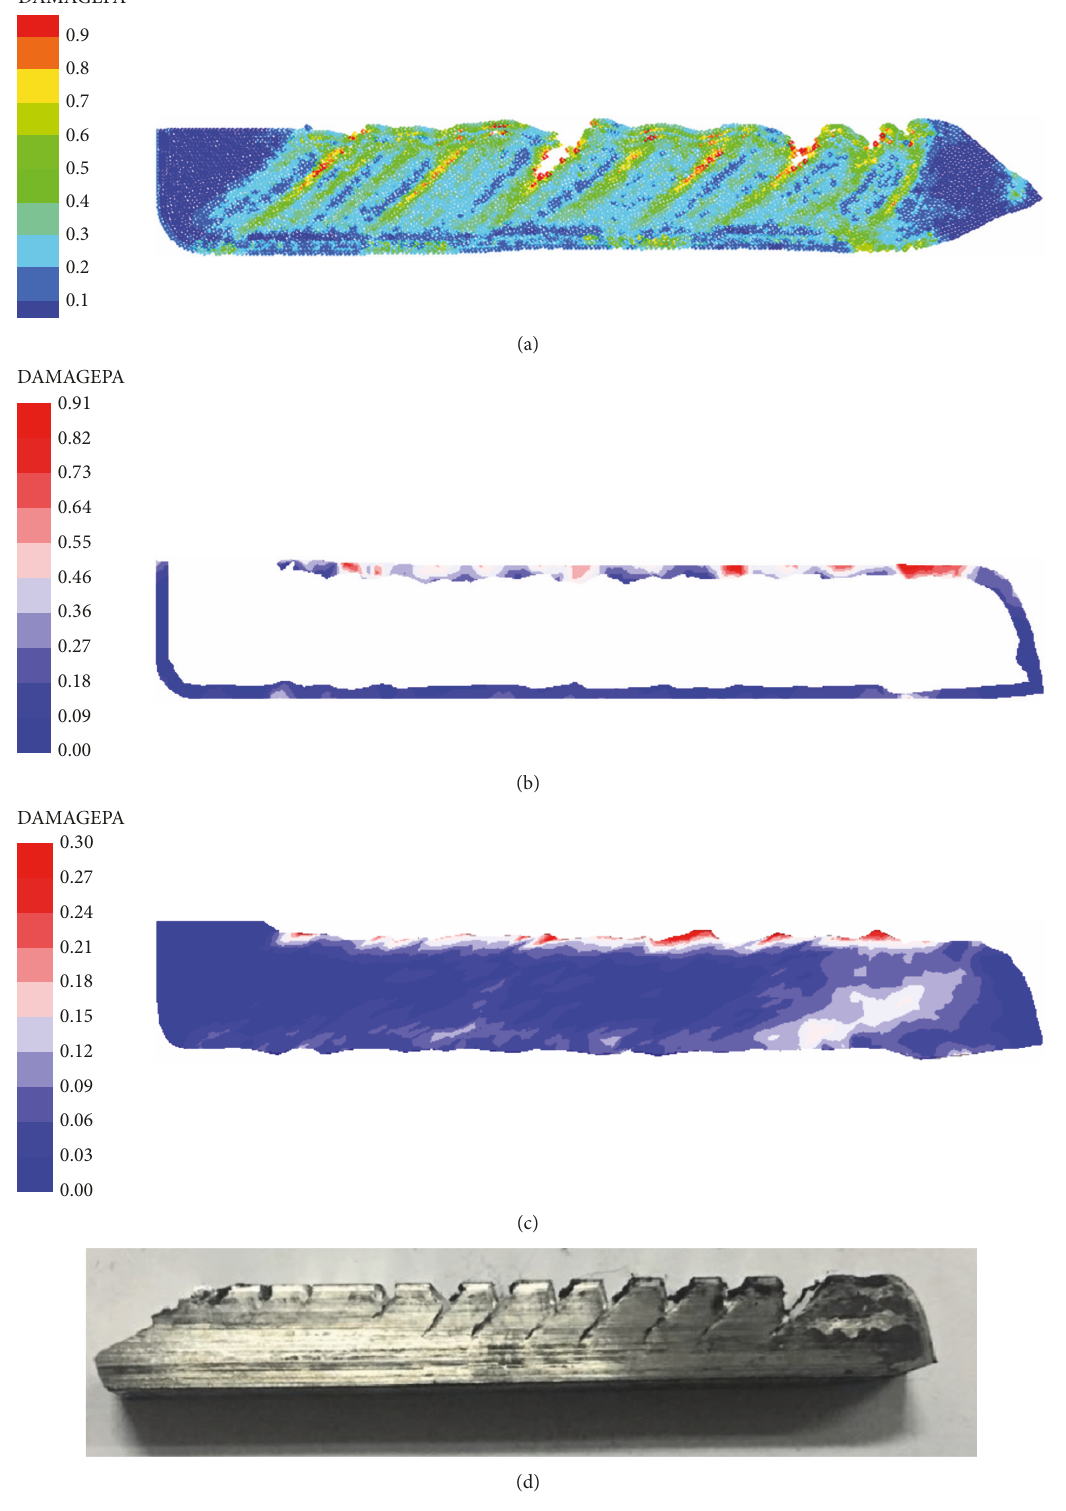
Figure 13: Simulated results of damage value distribution and test results. (a) Computation results based on SPH. (b), (c) Simulation results based on finite element method. (d) Test